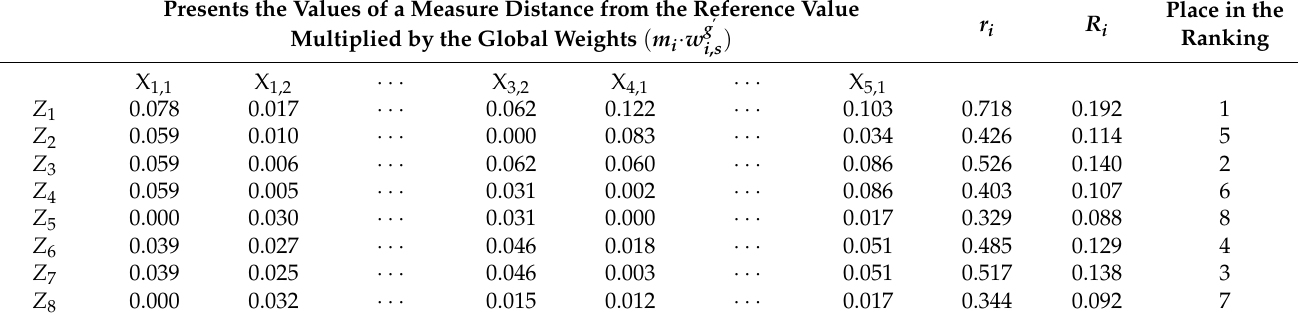
Table 9. Calculated values of distance measure and ranking coefficient